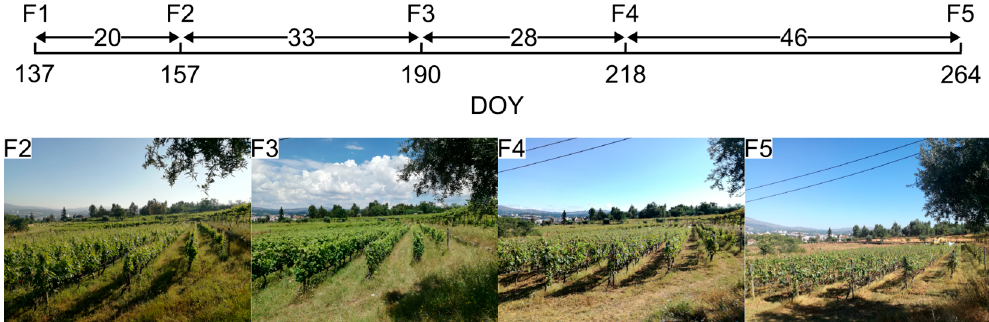
Figure 3. Flight campaigns’ details: flight number (F#), Day of Year (DOY), and temporal difference (in days) between flights. Vineyard images in different flight campaigns are also shown.